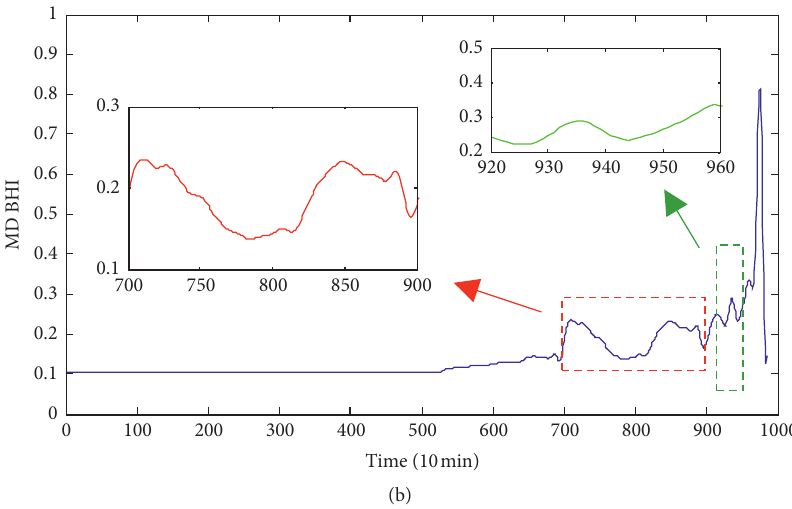
Figure 13: Description of bearing degradation trends: (a) DBHI and (b) MDBHI.